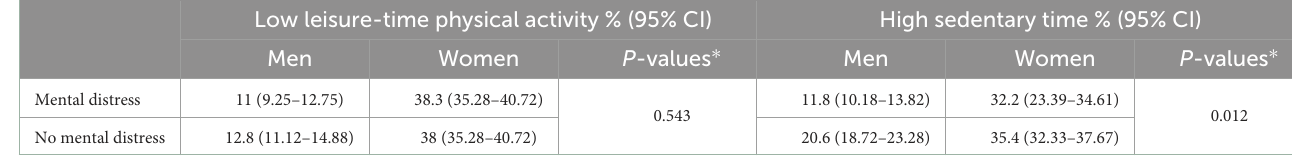
TABLE 1 Differences in mental distress between men and women with low level of leisure-time physical activity and high sedentary time. Low leisure-time physical activity % (95% CI)